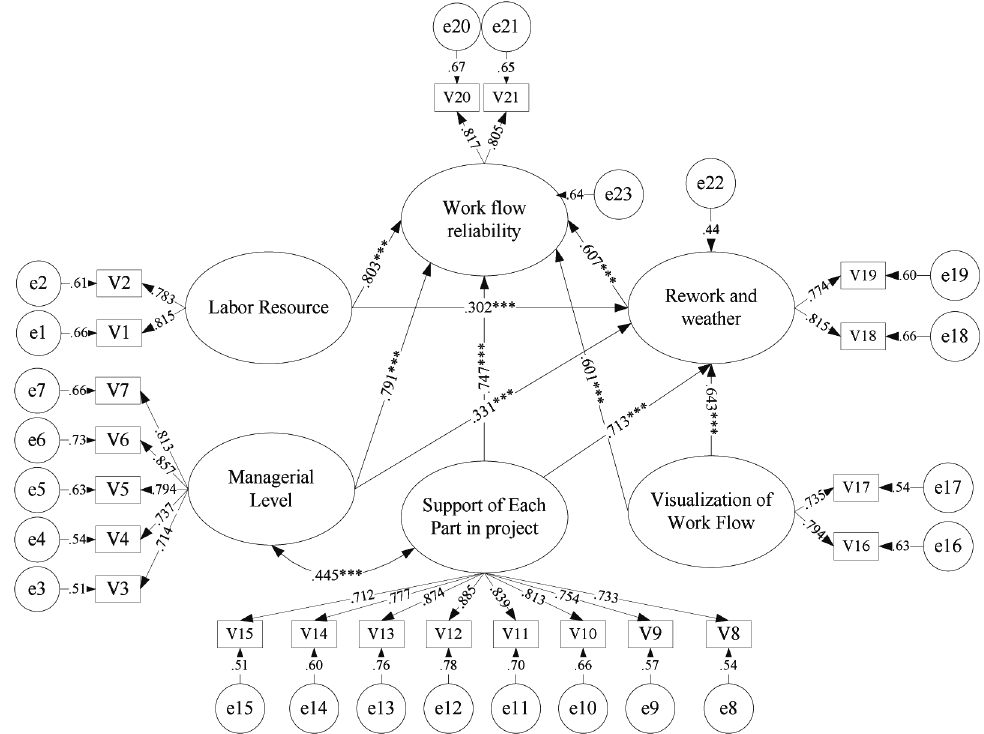
Fig. 3. Final SEM of the interrelationship framework between work flow reliability and critical factors Note : ***denote significance at p = 0.000 <